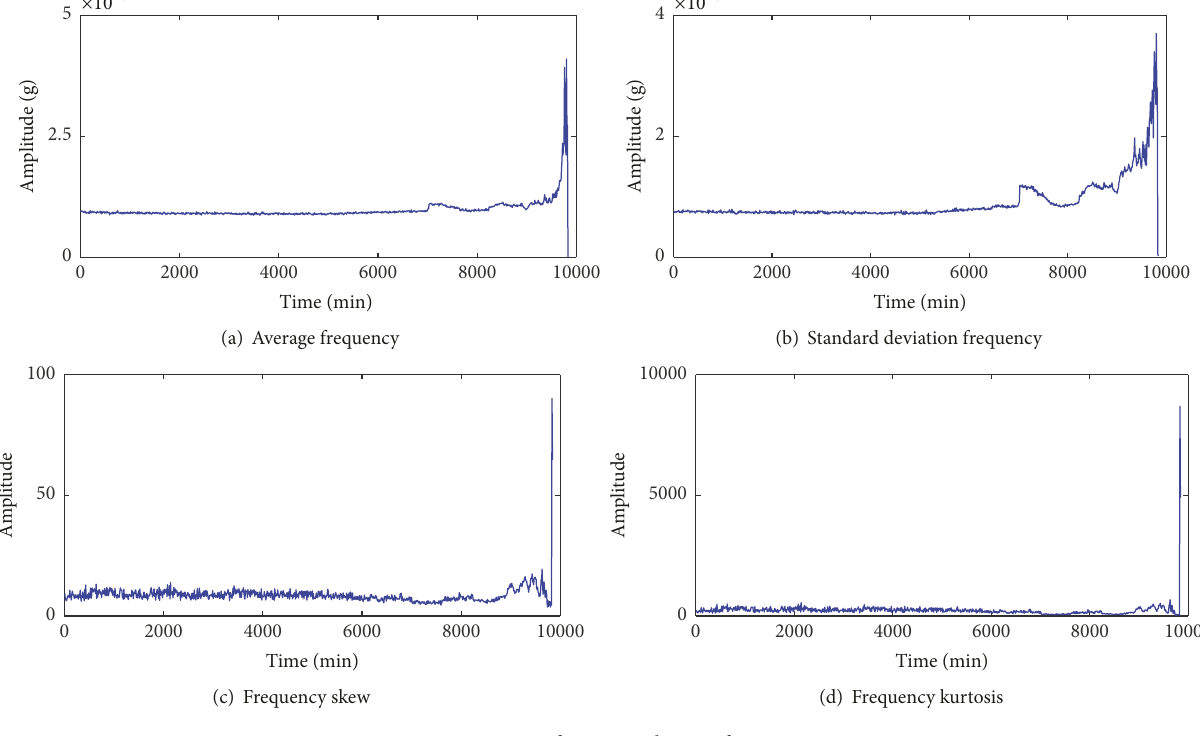
Figure 6: Four frequency domain features. Table 2: Evaluation results of the first eight best bearing